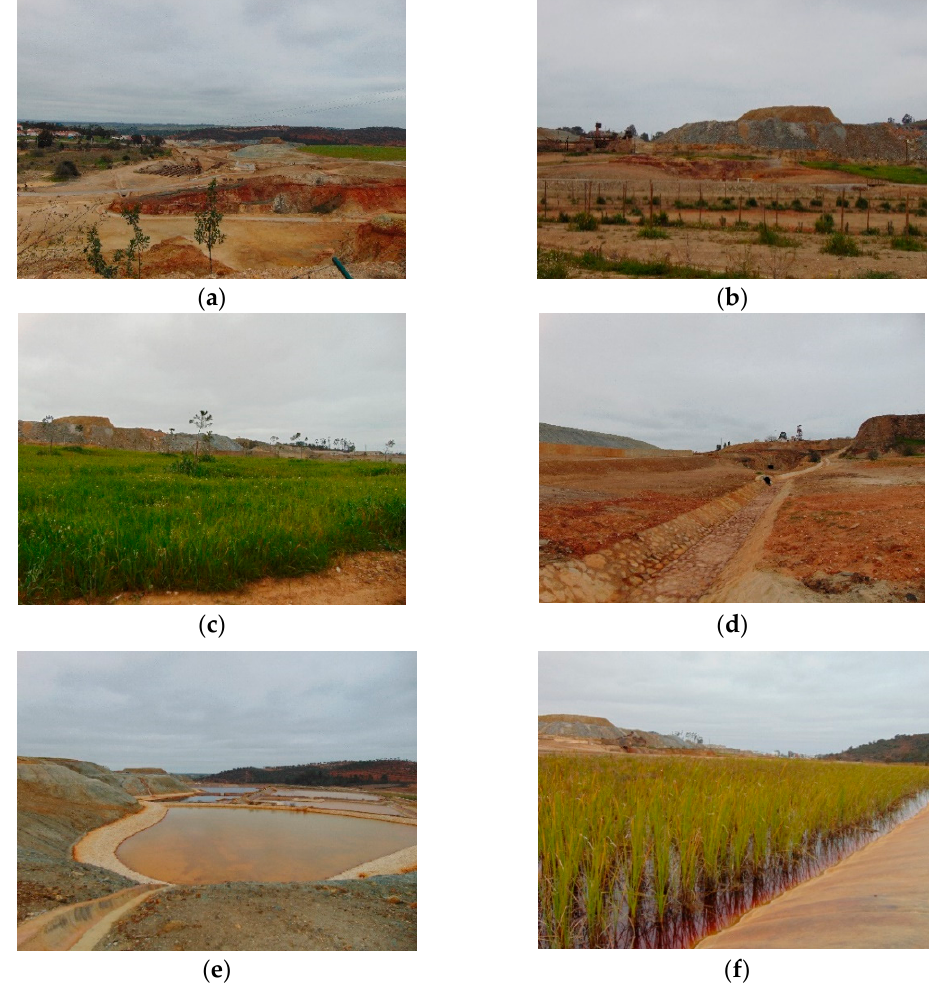
Figure 2. Remediation measures executed by EDM in the old part of the Aljustrel mine: ( a ) overall view; ( b ) confined materials deposited in Algares; ( c ) area covered with clean soil and revegetated with a mixture of herbaceous plants; ( d ) perimetral channels to collect the acid drainage waters; ( e ) evaporation-concentration ponds receiving the drained waters; ( f ) artificial wetland to treat AMD waters (images courtesy of Cátia Micaelo, December 2016).